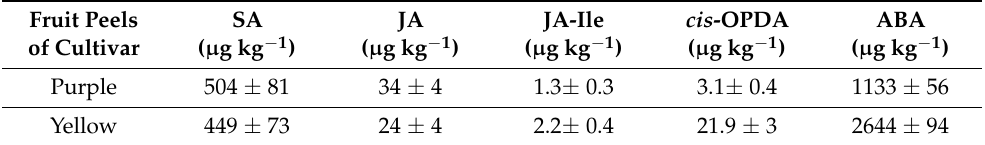
Figure 5. Determination of disease incidence (%), lesion diameter (mm) at12 dpi on yellow and purple passion fruits, inoculated by type-1 ( Fusarium kyushuense ), type-2 ( Fusarium concentricum ), type-3 ( Colletotrichum truncatum ), type-4 ( Alternaria alternata ), type-5 ( Cladosporium tenuissimum ), and type-6 ( Fusarium equiseti ) isolates. Results shown were obtained from ( A , B ) wounded fruits (1 × 10 6 conidia mL − 1 suspension) and from ( C , D ) non-wounded fruits (5 mm mycelial plug). Results are means ± standard error. Different letters (a/b) indicate significant differences between two cultivars. Table 4. Phytohormones levels in the peels of yellow and purple fruit